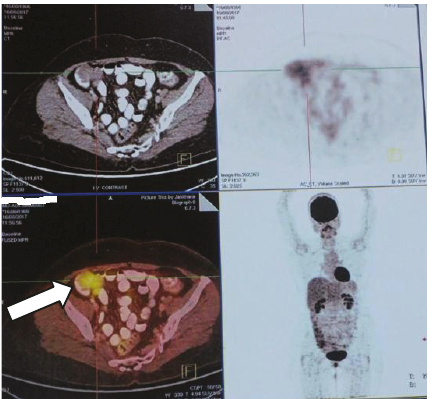
Figure 2: PET/CT scan showing well-de fi ned heterogeneously enhancing lesion in the right iliac fossa along the anterior abdominal wall.